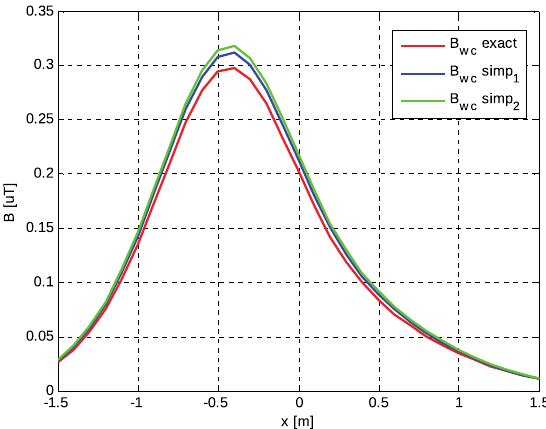
Figure 10. B WC , B WC,simp 1 , B WC,simp 2 versus horizontal distance x for the third case study.